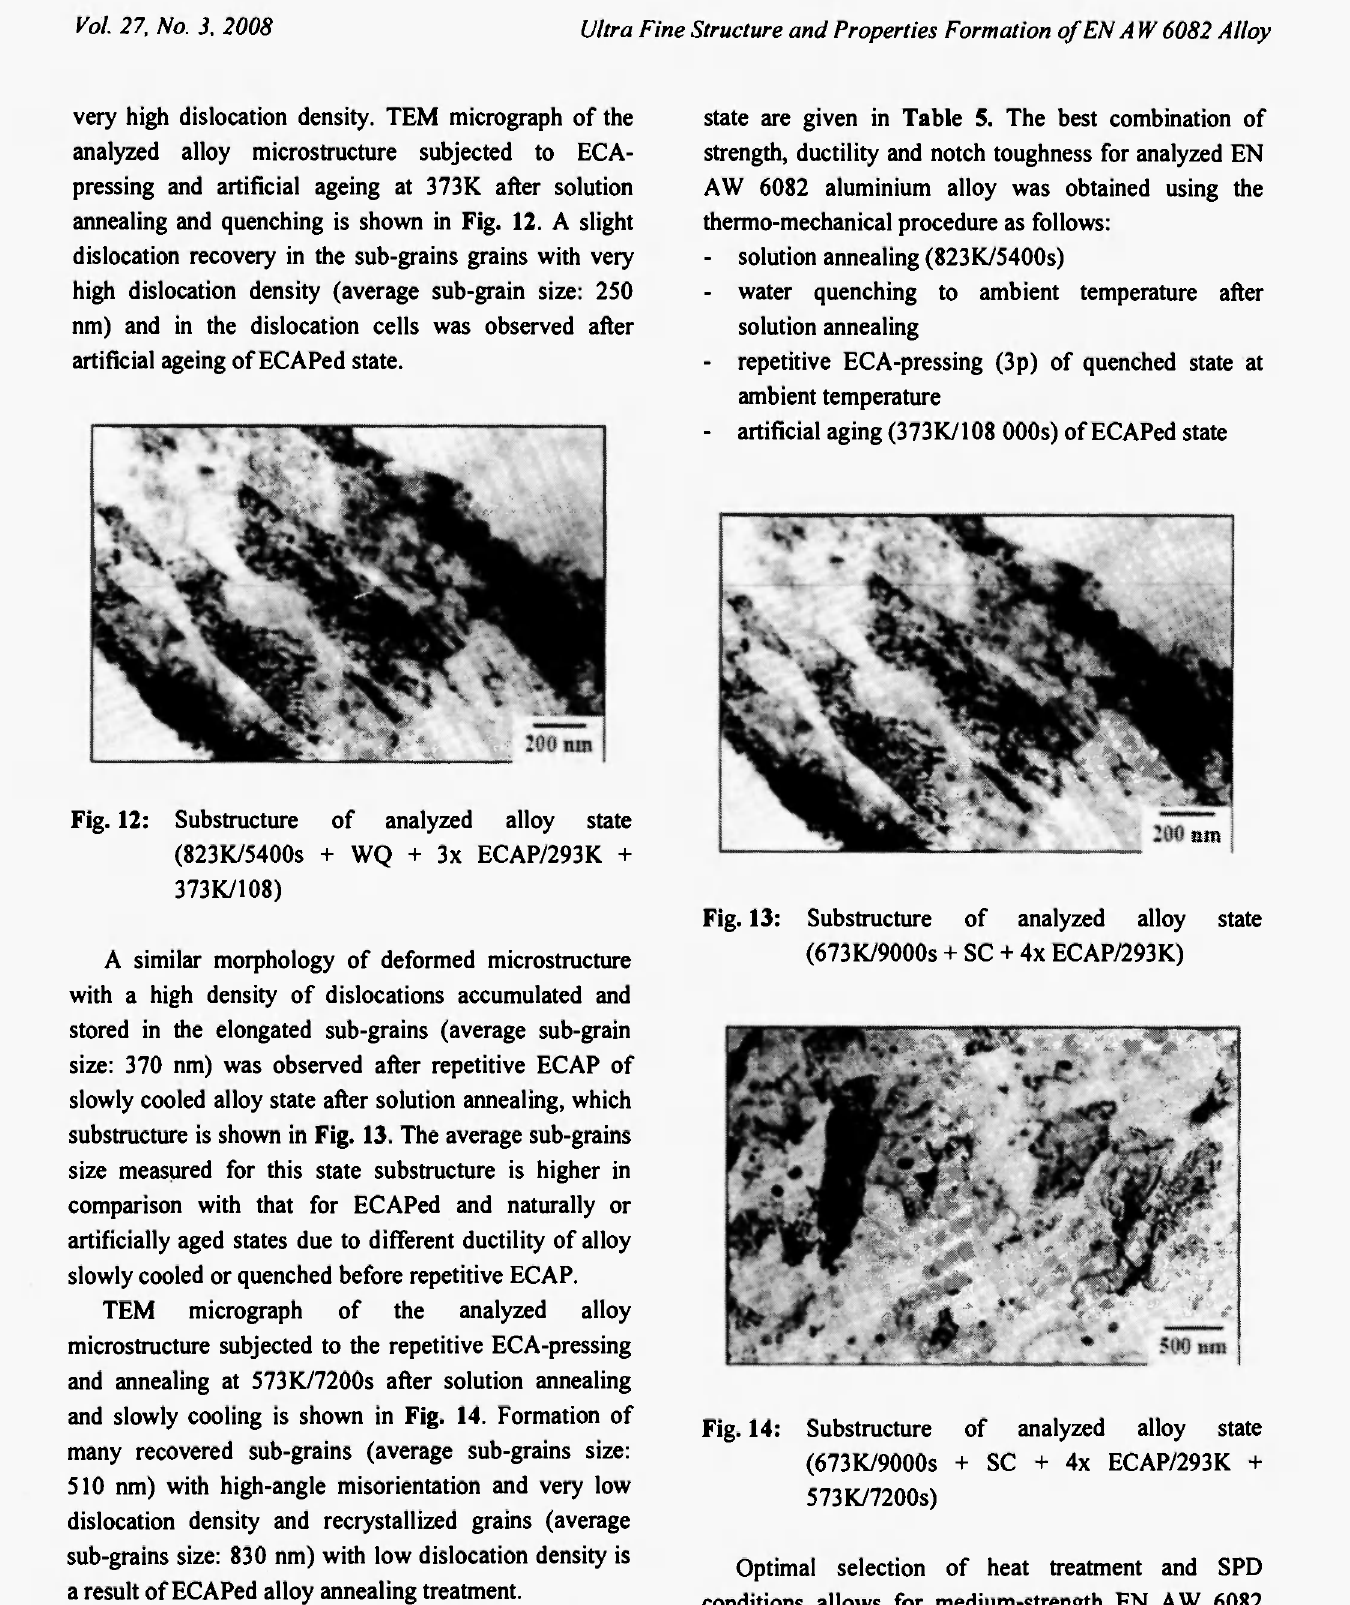
Fig. 14: Substructure of analyzed alloy state 573K/7200s) Optimal selection of heat treatment and SPD conditions allows for medium-strength EN AW 6082 alloy to achieve the equivalent properties as for industrially processed high-strength EN AW 7075 alloy.